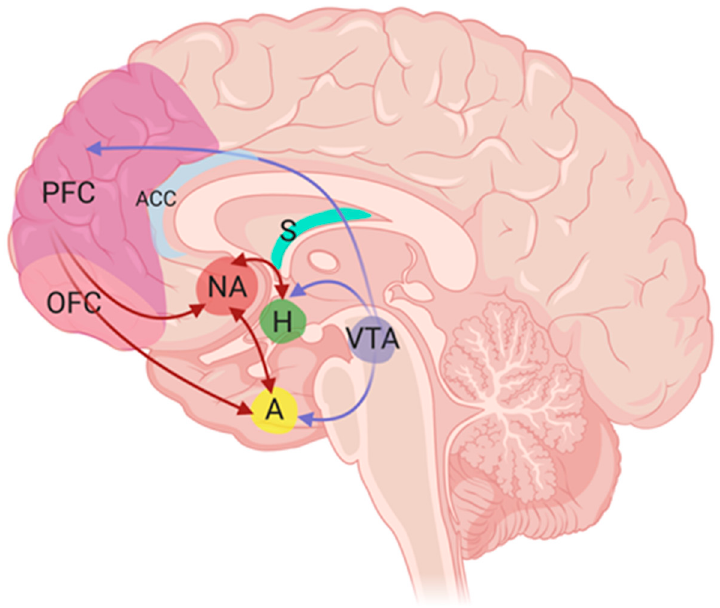
Figure 1. Limbic and reward pathways involved in eating behaviour and appetite. Eating behavior is closely associated with activity of the reward circuitry of the brain, which involves a group of neuronal structures that become activated and release dopamine when exposed to rewarding stimuli like food [27]. The pathway most associated with reward circuitry of the brain is referred to as the mesolimbic dopamine pathway, which starts with production and release of dopamine in the ventral tegmental area (VTA). The mesolimbic dopamine pathway then relays VTA signaling to the nucleus accumbens (NA), an area associated with motivation. The other aspect of the reward system is known as the mesocortical pathway which connects the VTA to the prefrontal cortex (PFC). This region also includes the orbitofrontal cortex (OFC), a key area involved in cognitive processes, such as decision making and memory. The PFC additionally forms connections with sensory and limbic pathways as well. Importantly, the reward pathway is activated, both before and after receipt of a reward suggesting that dopamine increases reward seeking behavior. Thus, any disruption of these pathways could potentially lead to disordered eating behavior. The VTA is also functionally and anatomically connected to the hypothalamus (H), primarily the lateral hypothalamus. The hypothalamus integrates homeostatic signals from various peripheral organs along with reward responses to modulate food intake and energy expenditure according to changes in metabolic state [28]. The arcuate nucleus of the hypothalamus (not shown), where neuropeptide Y (orexigenic) and proopiomelanocortin (anorexigenic) producing neurons reside, is the main area responsible for energy sensing and eating behavior. VTA, ventral tegmental area; NA, nucleus accumbens; H, hypothalamus; PFC, prefrontal cortex; OFC, orbitofrontal cortex; A, amygdala; ACC, anterior cingulate gyrus; S, striatum .